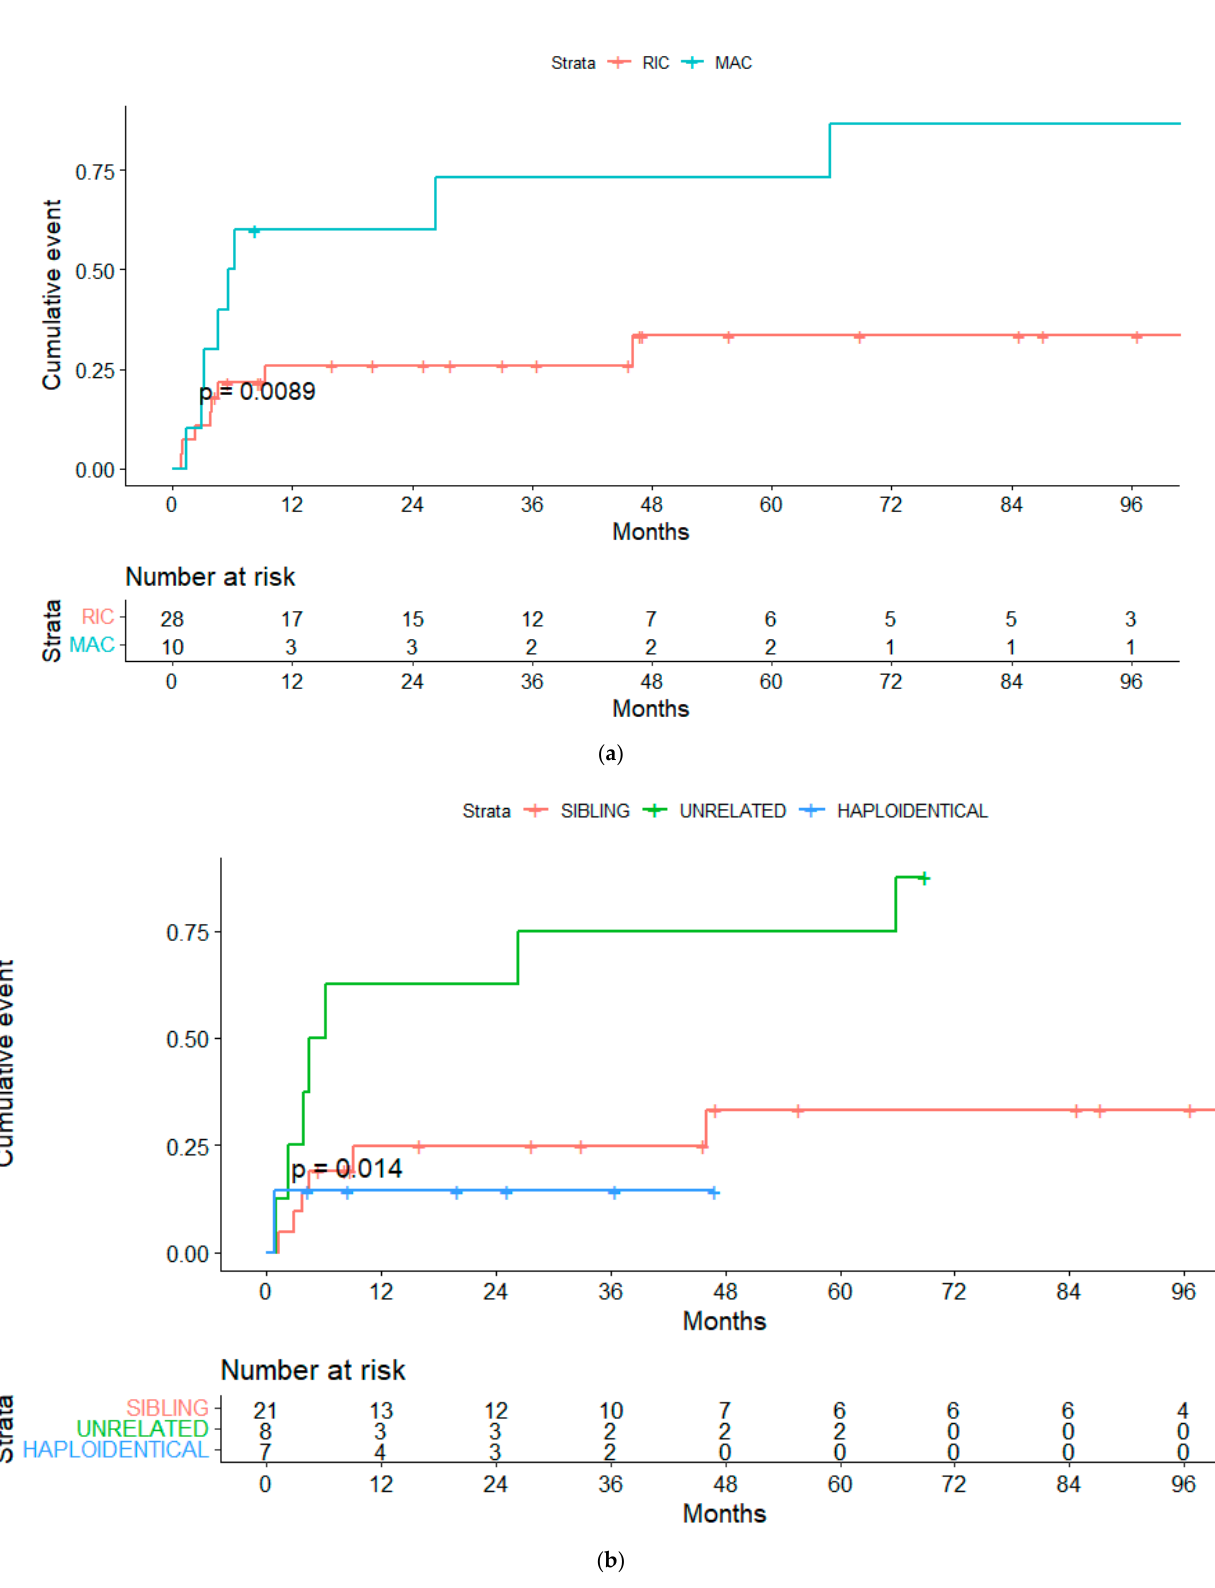
Figure 5. ( a ) Non-relapse mortality (NRM) for RIC and MAC regimens. ( b ) NRM for sibling vs. unrelated vs. haploidentical transplanta-tion.